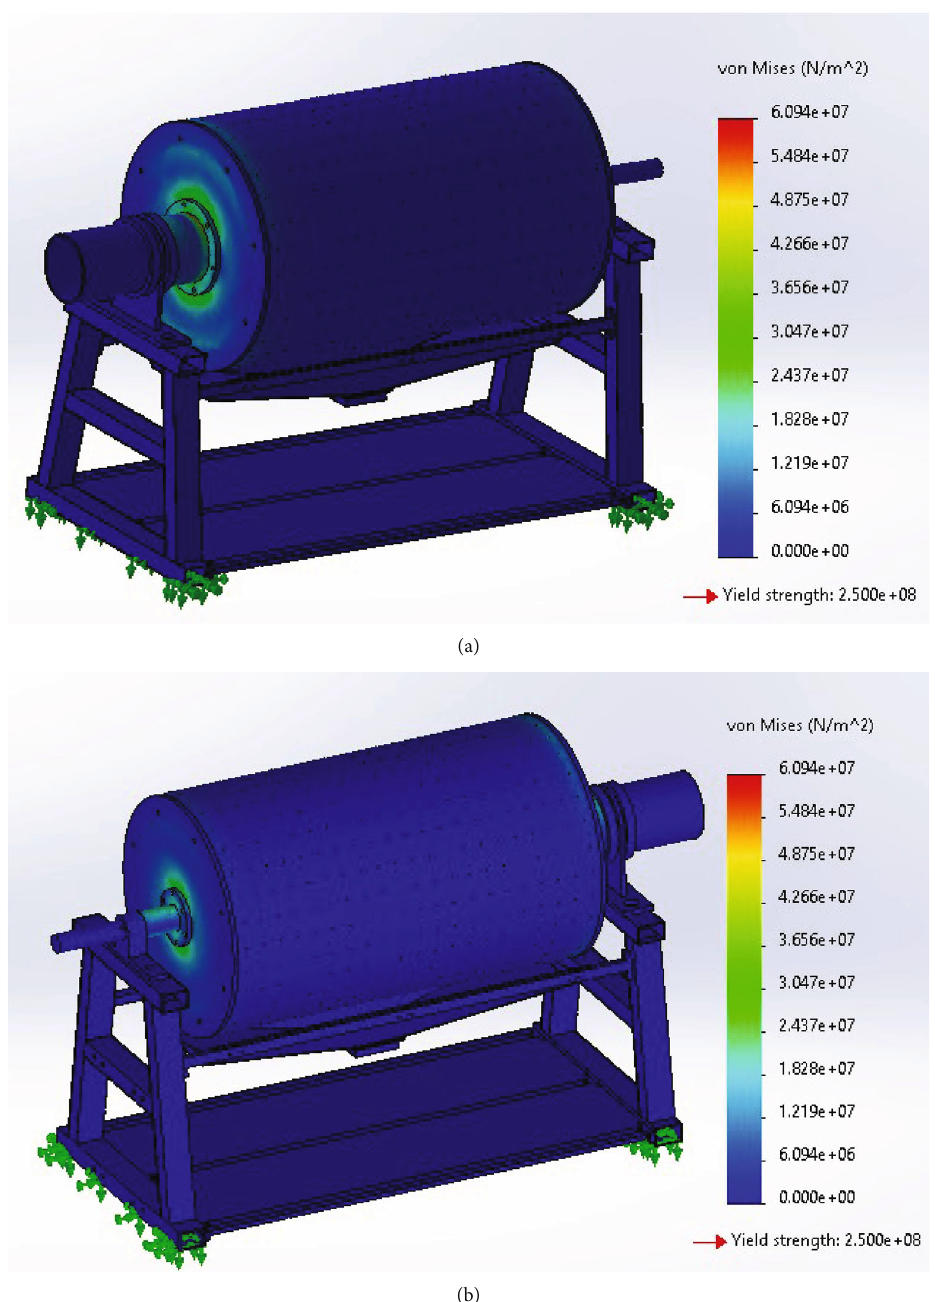
Figure 18: Von mises stress